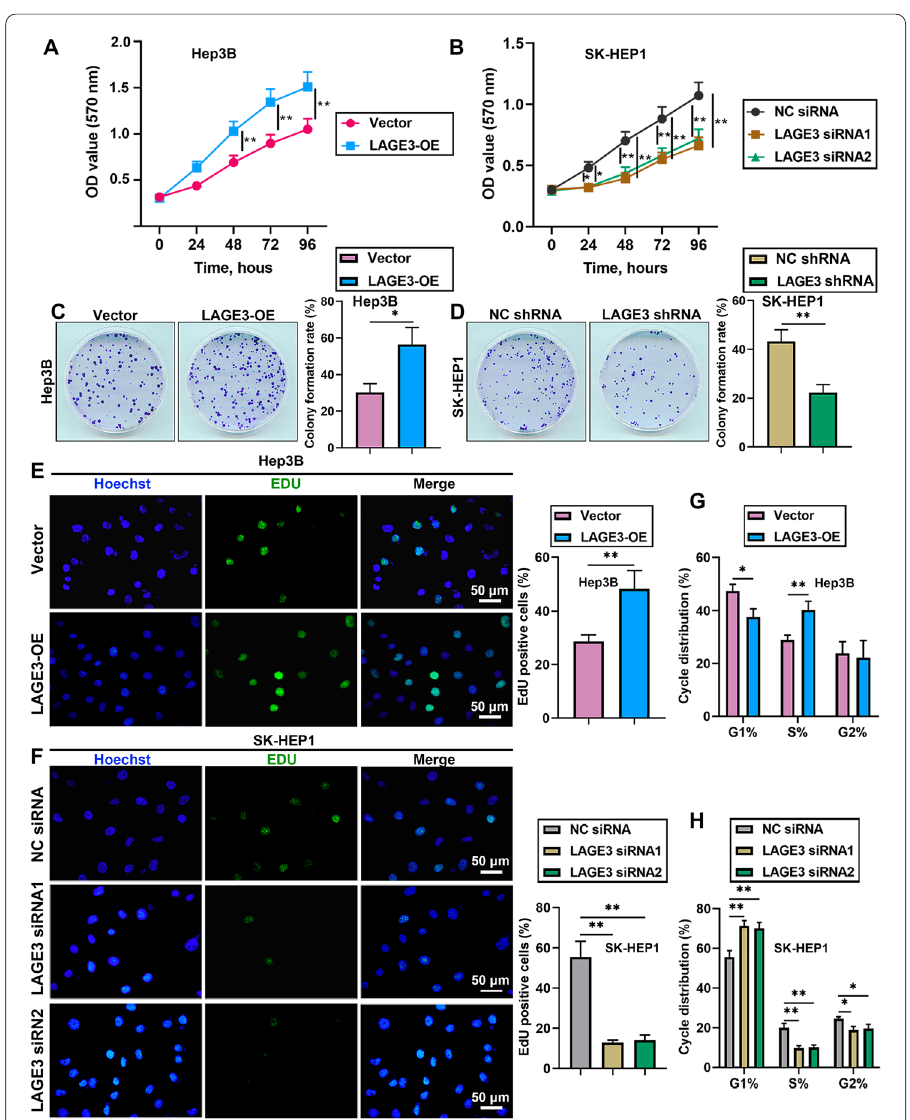
Fig. 2 LAGE3 promoted the proliferation of HCC cells. Hep-3B cells were transfected with LAGE3-OE and SK-HEP1 cells were transfected with LAGE3 siRNA1/2 or LAGE3 shRNA. A – B MTT assay was used to evaluate the proliferation of Hep-3B and SK-HEP1 cells. C – D Colony formation assay was employed to assess the colony formation ability of Hep-3B and SK-HEP1 cells. E – F EdU-stained HCC cells. G–H Cell cycle analysis of HCC cells. Data are shown as mean standard deviation. *p < 0.05, **p < ±